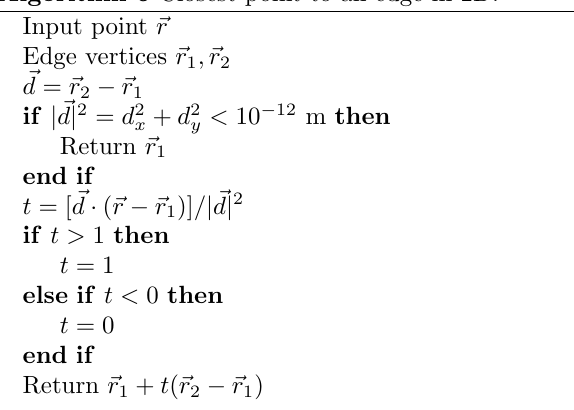
Figure 21: Possible splitting cracks in the ice floe